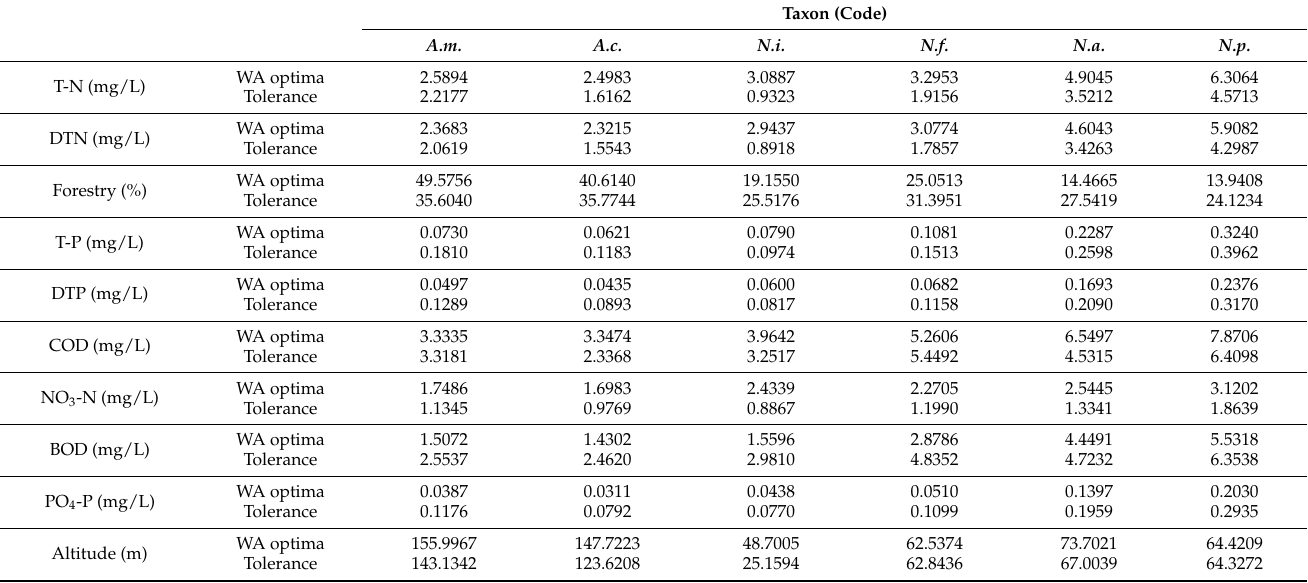
Table 6. Optima and tolerance for six dominant species using weighted averaging